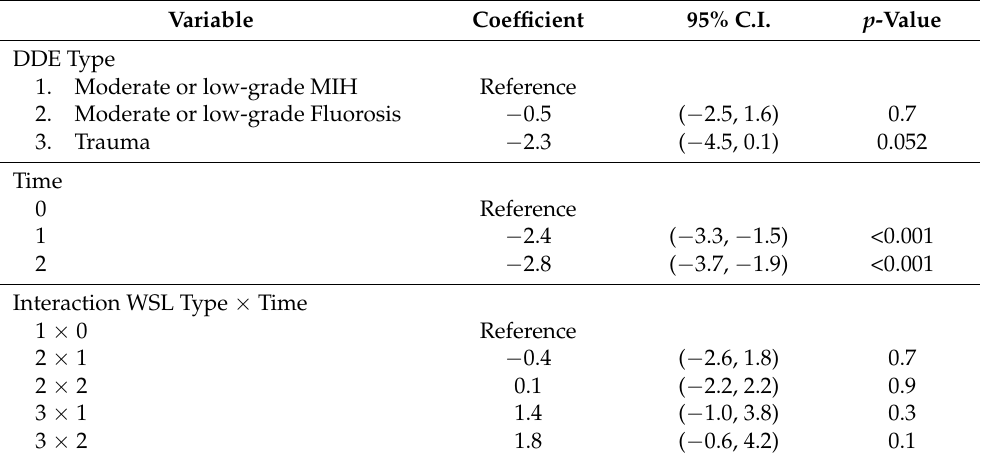
Table 4. Mixed model regression on Wong–Baker Faces Pain Rating Scale.